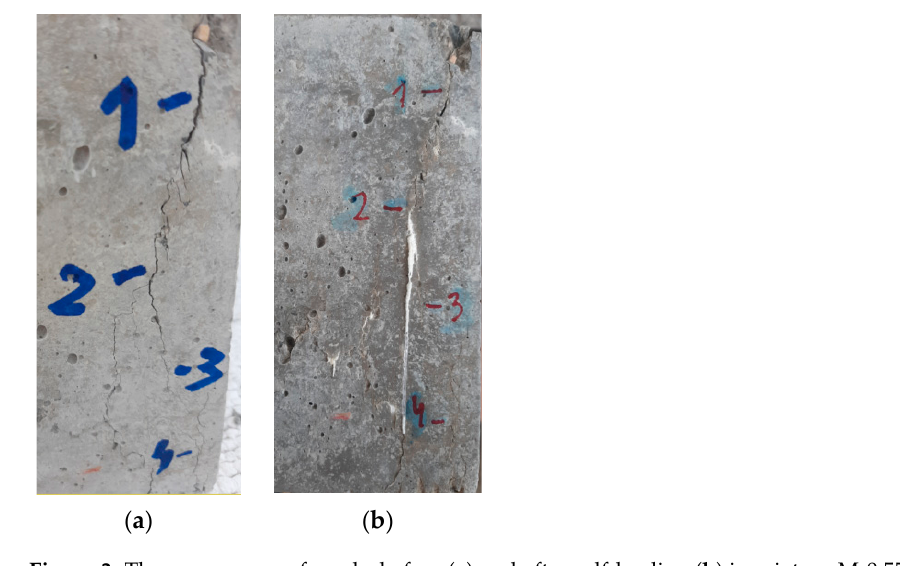
Figure 3. The appearance of cracks before ( a ) and after self-healing ( b ) in mixture M-0.55-CWA. According to the authors in [35,36], in concrete with higher compressive strength, the initial cracks develop with a larger width than in concrete with lower compressive strength. From the observation of the initial crack pattern in Table S1, it cannot be concluded whether concrete with higher or lower compressive strength develops a larger number of cracks with larger width immediately after loading. Nevertheless, it can be observed (Table S1) that in the M-0.45-R mix, 6 cracks healed at a percentage greater than 90%, while in the M-0.45-CWA mix, 10 cracks healed at a percentage greater than 90%. In the M-0.55-R mix, 7 cracks healed while in the M-0.55-CWA mix, 10 cracks healed with the same percentage. Although it was concluded in [35] that the effect of self-healing is more pronounced in concrete with higher strength, this is not confirmed here—namely, the M-0.45-CWA and M-0.55-CWA mixes have the same number of cracks healed above 90%. It is known that cracks as small as 0.1 can be healed by autogenous healing [16,37]. However, considering the width of cracks healed over 90%, it can be observed that a larger number of cracks healed with a width of 0.15 mm in concrete mixes with CWA than in reference concrete mixes (3 cracks with a width of 0.15 mm healed in mixes M-0.45-CWA and M-0.55-CWA, while only 1 crack healed in mixes M-0.45-R and M-0.55-R). The influence of CWA on crack healing was thus confirmed. The fact that there are cracks up to 0.15 mm wide in mixes with CWA that did not heal completely indicates that the CWA is not evenly distributed in the mix. The individual results presented in Table S1 were further divided into three groups based on their self-healing ability, and an average crack width was determined for each mix and group. These results, shown in Table 5, indicate that CWA can ensure self-healing of cracks, but the efficiency of self-healing is highly dependent on the initial crack width.